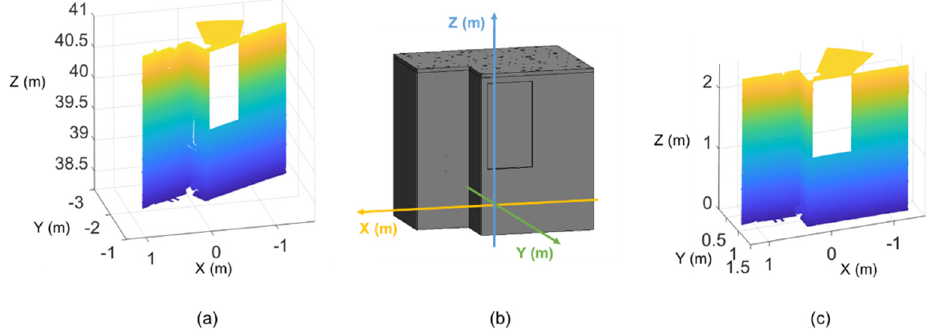
Figure 14. Scan-BIM registration: ( a ) scanned data in LiDAR’s coordinate system, ( b ) as-designed BIM in user-defined coordinate system, and ( c ) scanned data after registration.